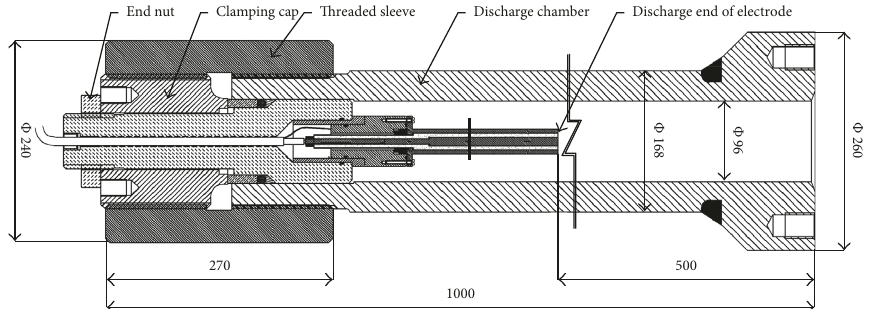
Figure 2: Schematic diagram of the discharge chamber structure.